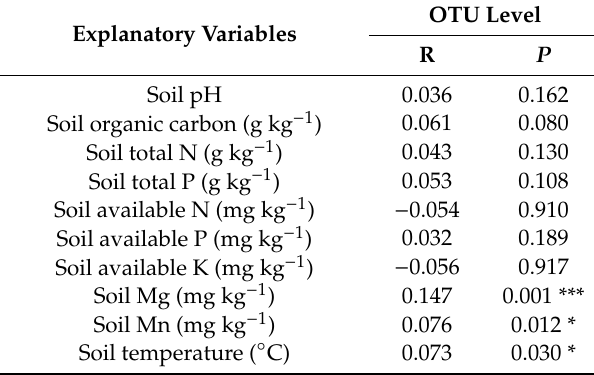
Table 3. Relationships between AMF community compositions and environmental factors, as revealed by the partial Mantel